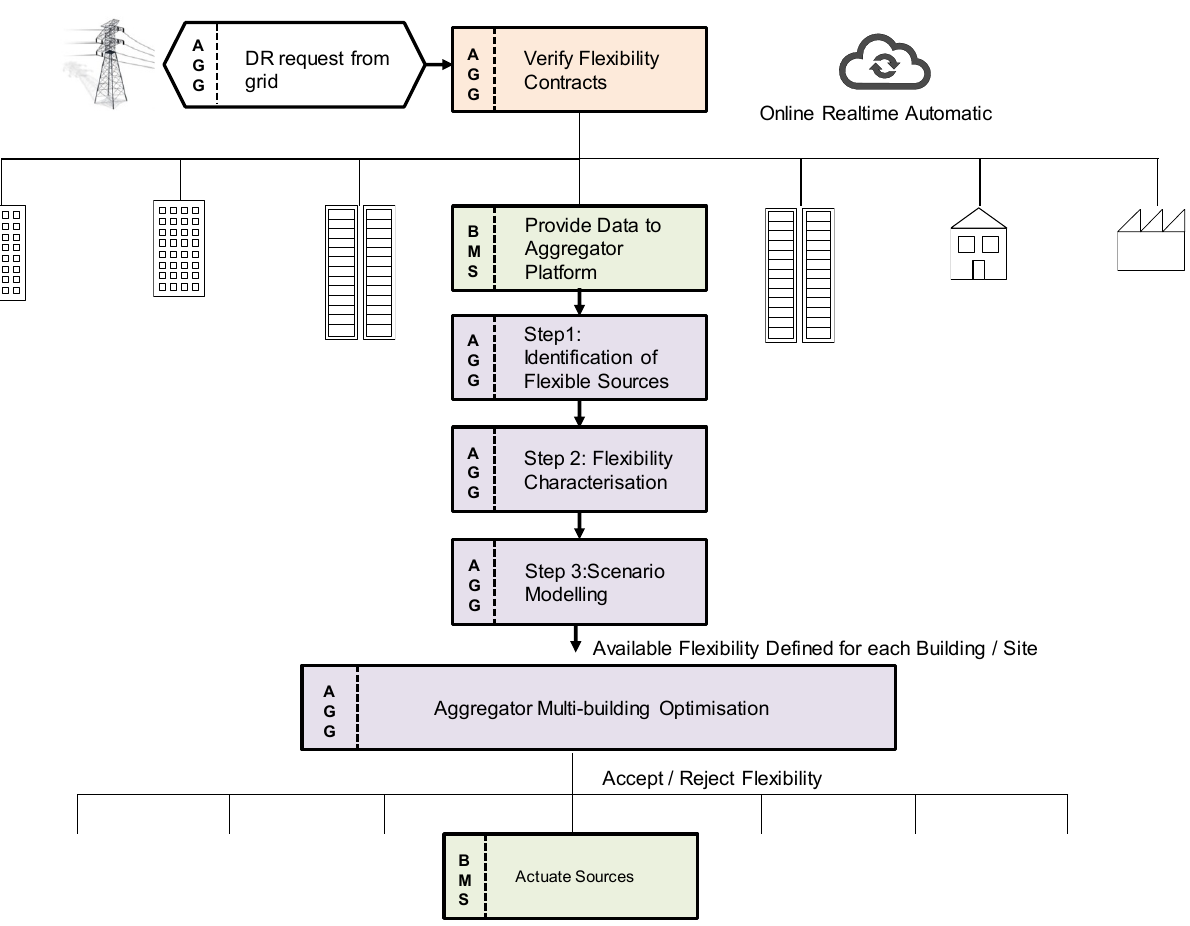
Figure 1. Aggregator-based online real-time automated implementation of flexibility assessment.